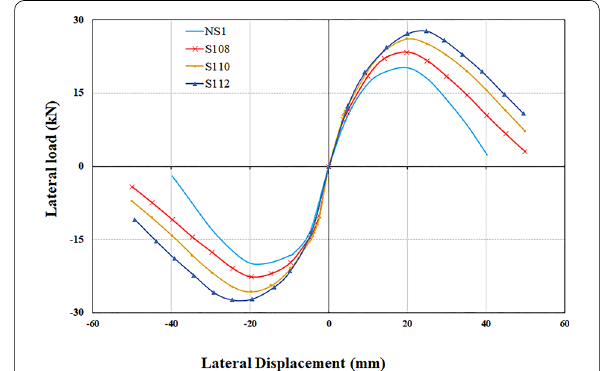
Fig. 6 Force–displacement envelope curves of